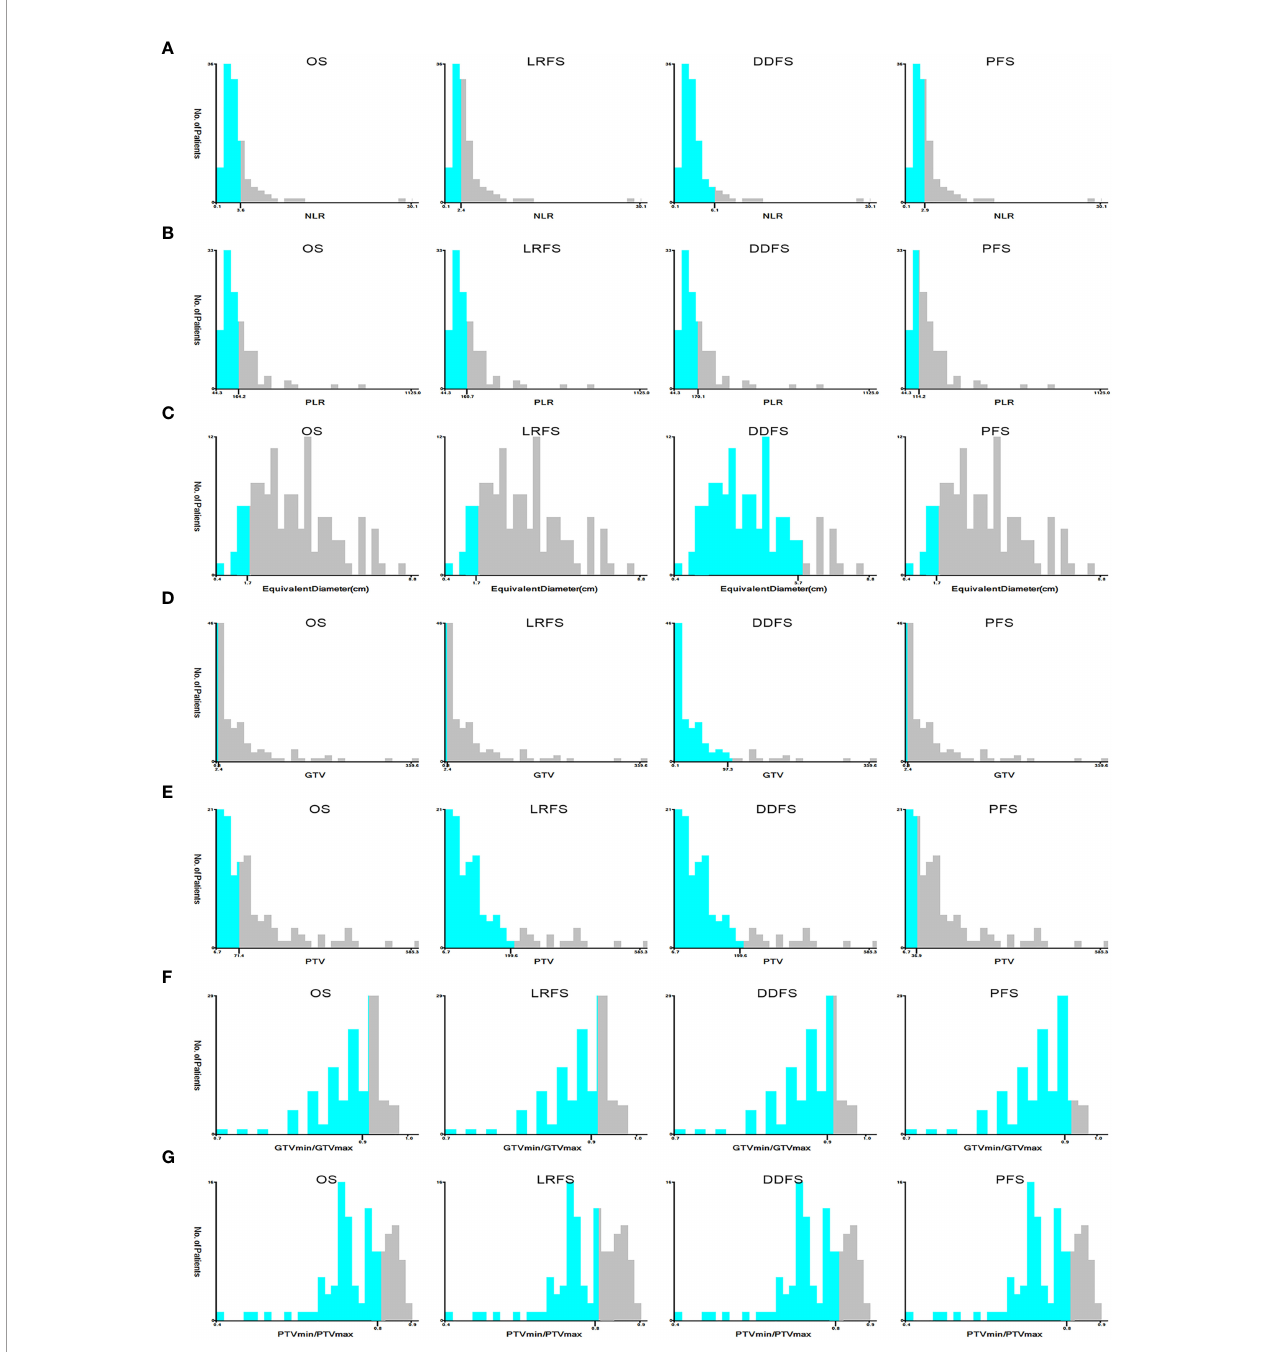
FIGURE 3 | The optimal cut-off values of NLR (A) , PLR (B) , equivalent diameter (C) , GTV (D) , PTV (E) , PTVmin/PTVmax (F) , GTVmin/GTVmax (G) in prognosis of OS, LRFS, DDFS and PFS by X-tile software. NLR, Neutrophil-to-Lymphocyte ratio; PLR, Platelet-to-Lymphocyte ratio; GTV, gross tumor volume; PTV, planning target volume; PTVmin/PTVmax, dose inhomogeneity of PTV; GTVmin/GTVmax, dose inhomogeneity of GTV; OS, overall survival; LRFS, local recurrence free survival; DDFS, distant disease-free survival; PFS, progression free